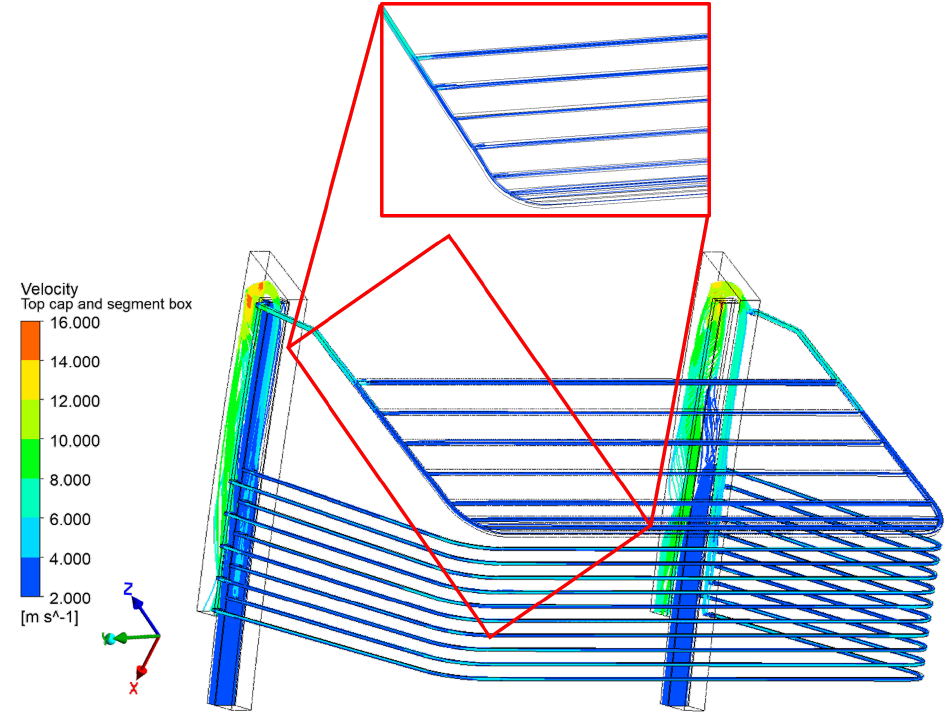
Figure 7. Fluid velocity in the SB cooling